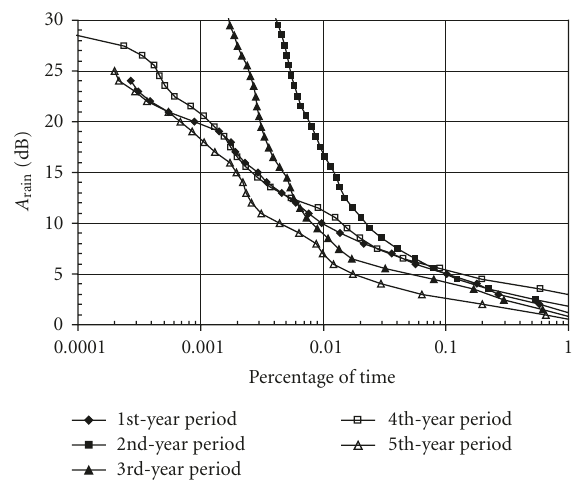
Figure 3: CDs of rain attenuation for individual 1-year periods.